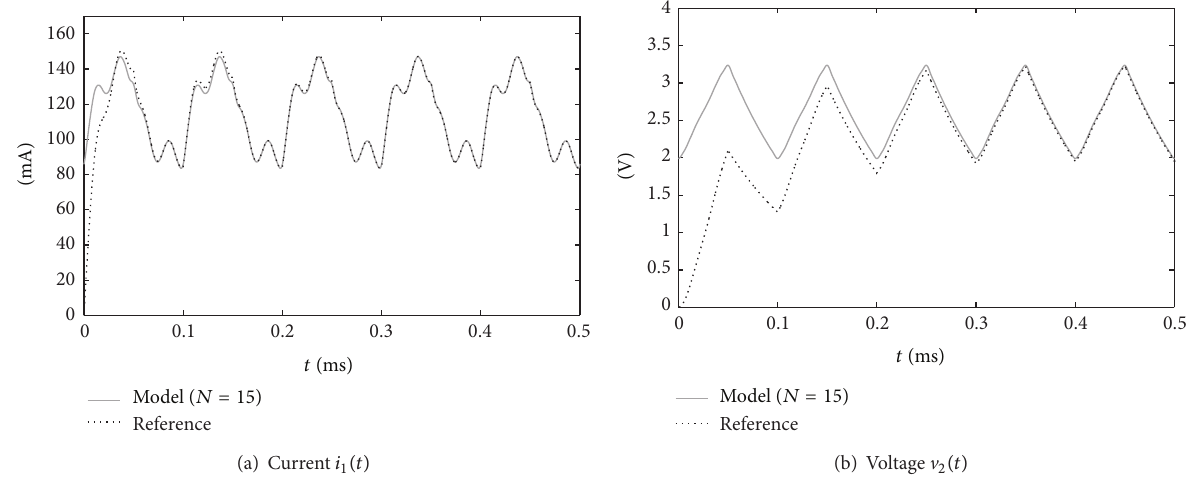
Figure 7: Time-domain voltage and current responses of the circuit of Figure 6. The reference curves are compared with the solutions arising from (32) and the order of expansion 𝑁 = 15 .